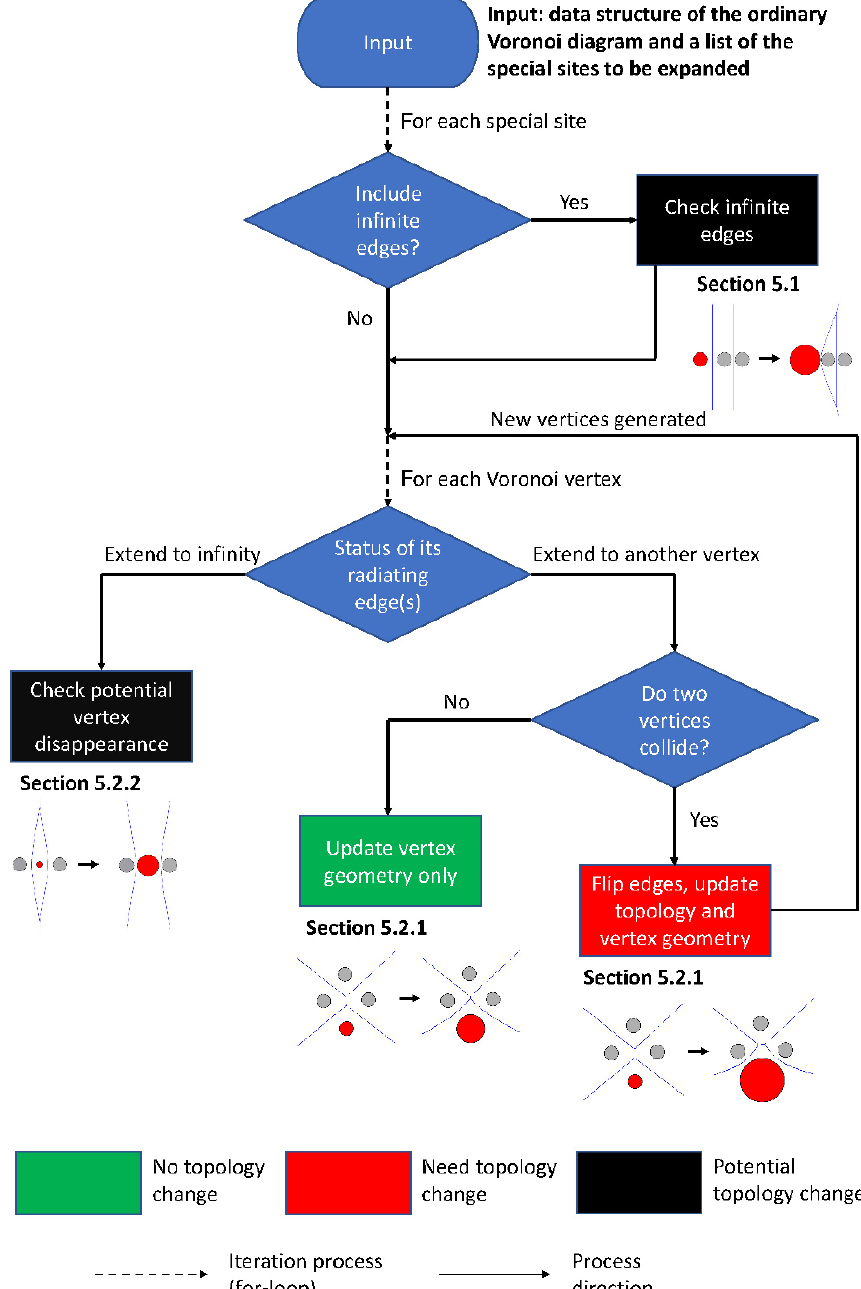
Fig. 17 Summary of the cell-expansion